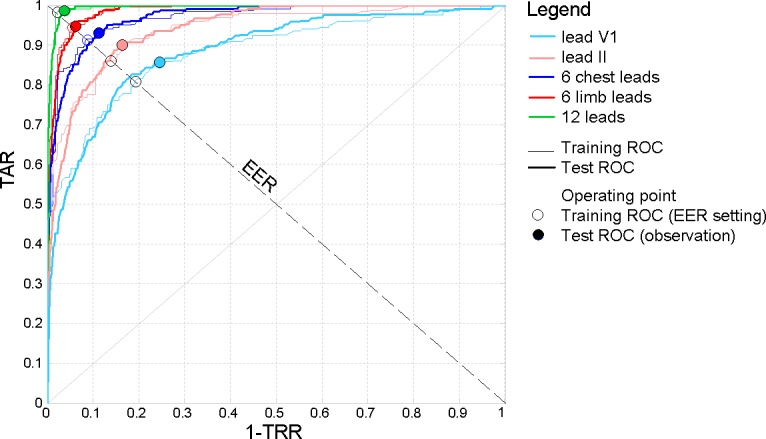
Training and test ROC curves of single and multi-lead ECG sets.The line EER (TAR = TRR) illustrates the choice of the operating point on the training ROC.